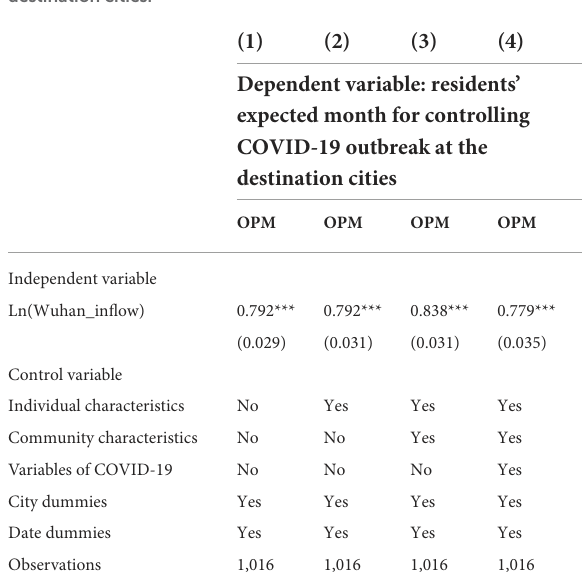
TABLE 3 The impact of population inflow from Wuhan city on residents’ expected month for controlling COVID-19 outbreak at the destination